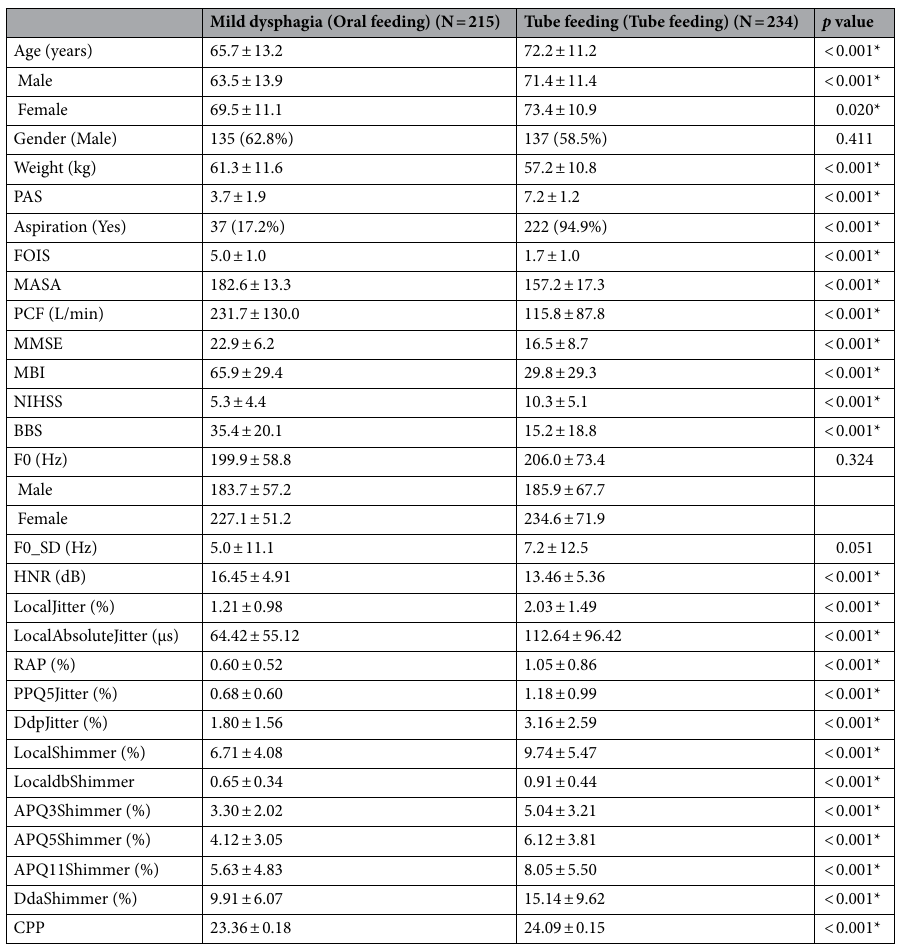
Table 1. Demographic features and acoustic parameters between mild versus severe dysphagia. Values are presented in mean ± standard deviation (SD) or number (%). * p < 0.05 is used for statistical significance. PAS penetration-aspiration scale, FOIS functional oral intake scale, MASA mann assessment of swallowing ability, PCF peak cough flow, MMSE mini-mental state examination, MBI modified barthel index, NIHSS national institutes of health stroke scale, BBS berg balance scale, F0 fundamental frequency, HNR harmonic to noise ratio, RAP relative average perturbation, PPQ period perturbation quotient, APQ amplitude perturbation quotient, CPP cepstral peak